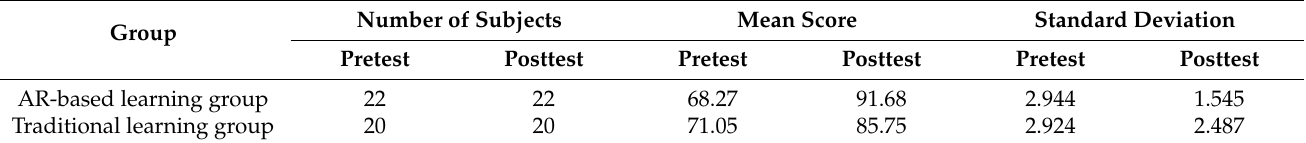
Table 5. Descriptive statistics of the pretest and posttest results of learning